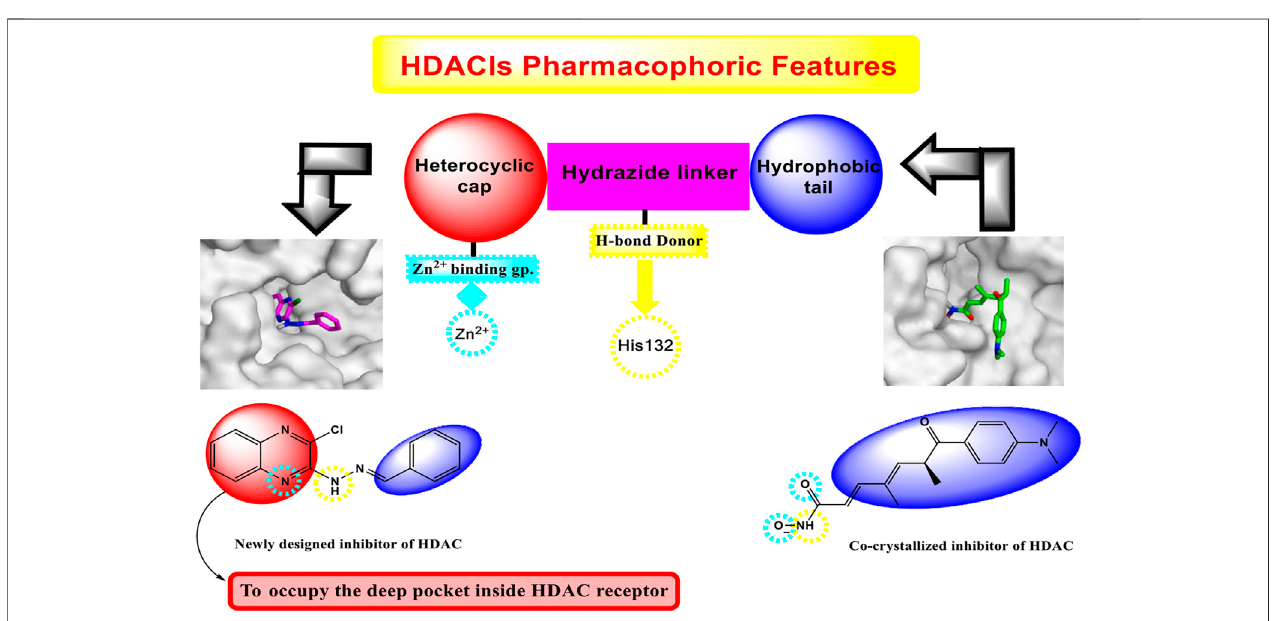
FIGURE 2 | Graphical representation explaining the new idea of our